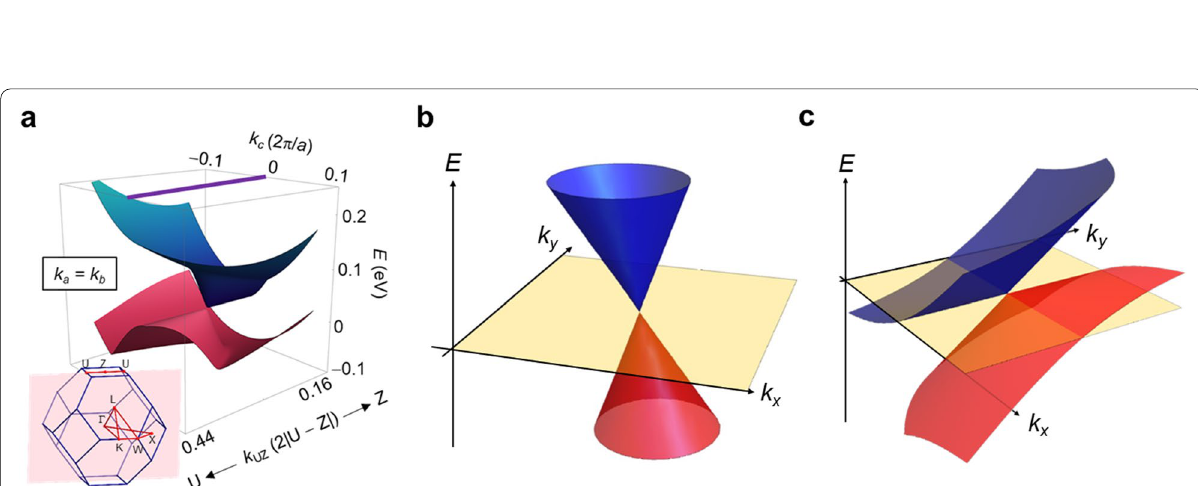
Fig. 5 Quantum Lifshitz phase transition and the Weyl ferromagnet Co 2 MnGa [15]. a Weyl point near the quantum Lifshitz transition in Co 2 MnGa, b Type-I Weyl point, and c Type-II Weyl point. The inset of a depicts the Brillouin zone. The vertical axis of the figure corresponds to energy, and the two horizontal axes correspond to the xy plane in momentum space. The valence band (red) and the conduction band (blue) touch at the Weyl point. The band structure becomes conical in the vicinity of the Weyl point, reflecting the linear dispersion. b When the Fermi energy (yellow) is adjusted to the Weyl point position, the Fermi surface becomes the Weyl point for type-I materials. c In type-II materials, the valence and conduction bands form hole and electron pockets respectively. A large Fermi surface is created by the two, which meet at the Weyl